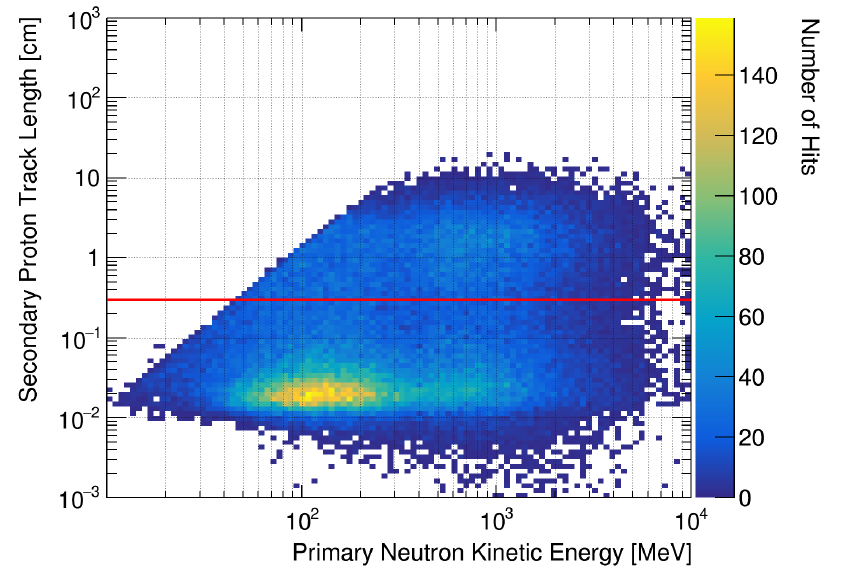
Figure 27. Track length of recoiling protons for neutrons produced in 100,000 neutrino interactions. About 30% of all recoils are resolvable as tracks with the LArPix pixel charge-readout system. The horizontal red line denotes the 3 mm charge-readout pixel pitch, which is considered the minimum length for resolving the corresponding energy deposits as a particle